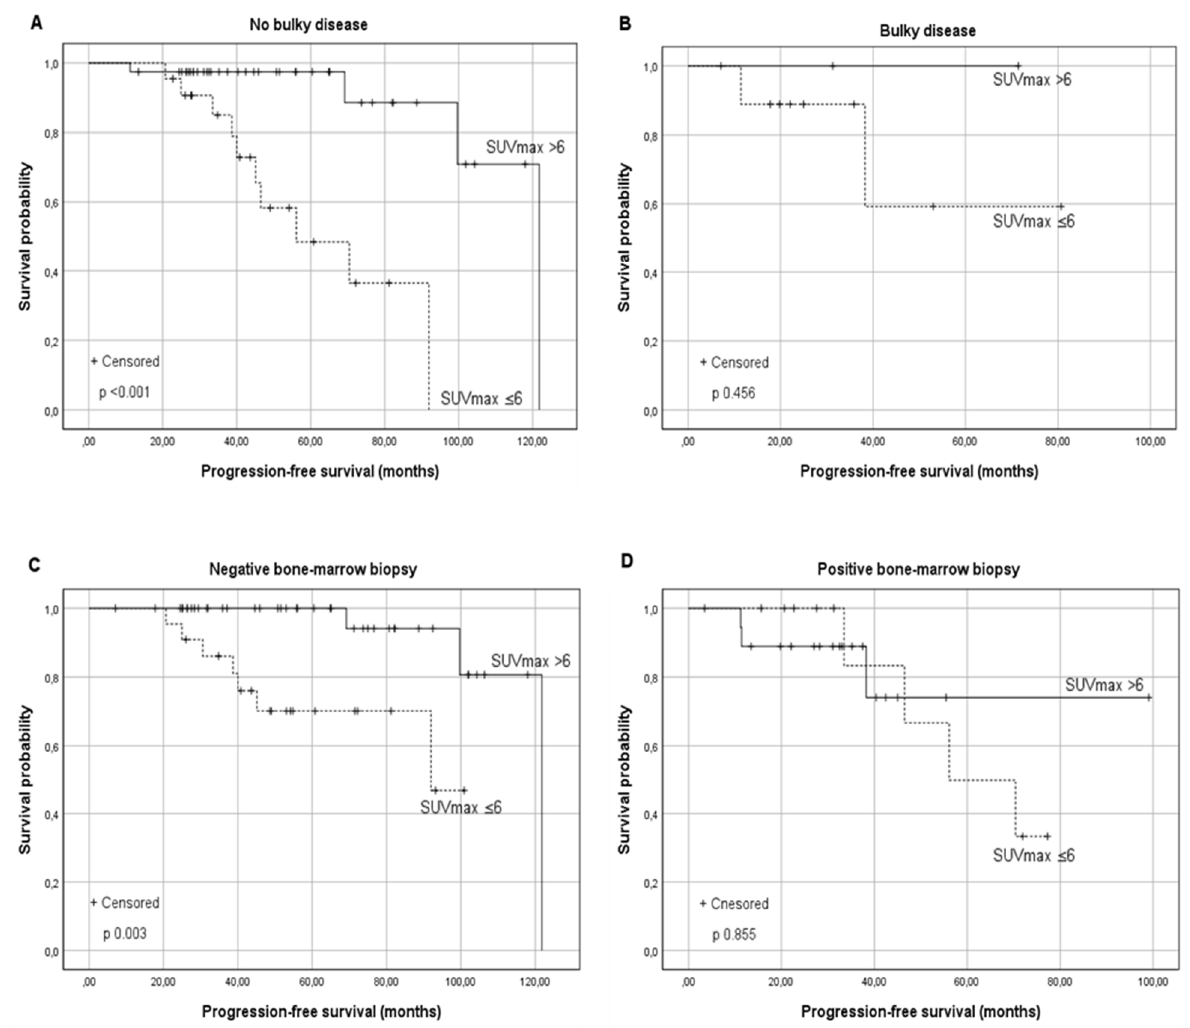
Figure 2. Kaplan–Meier survival curves for the progression-free survival (PFS) according to the baseline SUV max in relationship to risk factors: ( A ) FL without Bulky disease, ( B ) FL with Bulky disease, ( C ) FL without Bone Marrow involvement, and ( D ) FL with Bone Marrow involvement. Similar results were found in the presence and absence of other risk factors reported in Table 2.